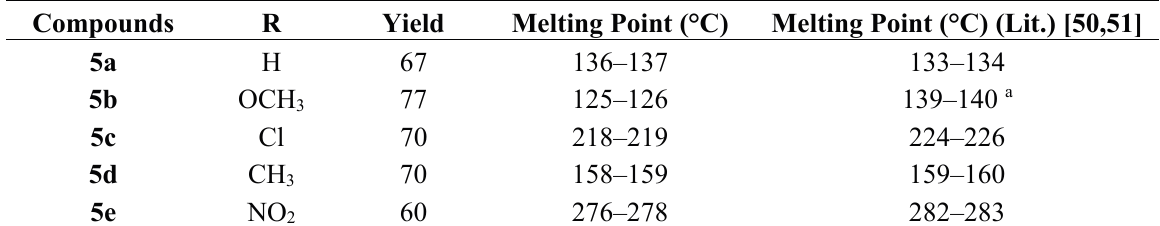
Table 5. Yield and melting point data of the compounds 5a – e .